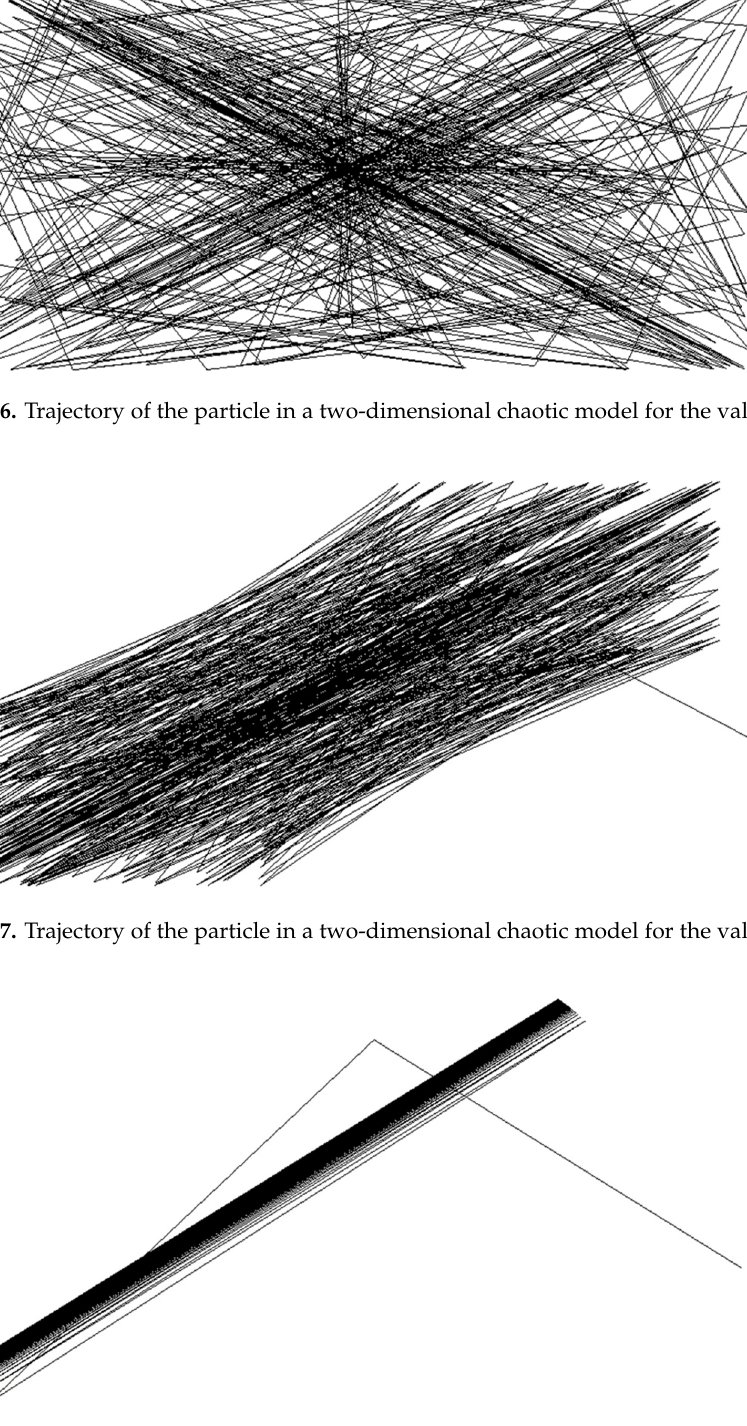
Figure 8. The trajectory of the particle in a two-dimensional chaotic model for the value of parameter, p = 0.5.